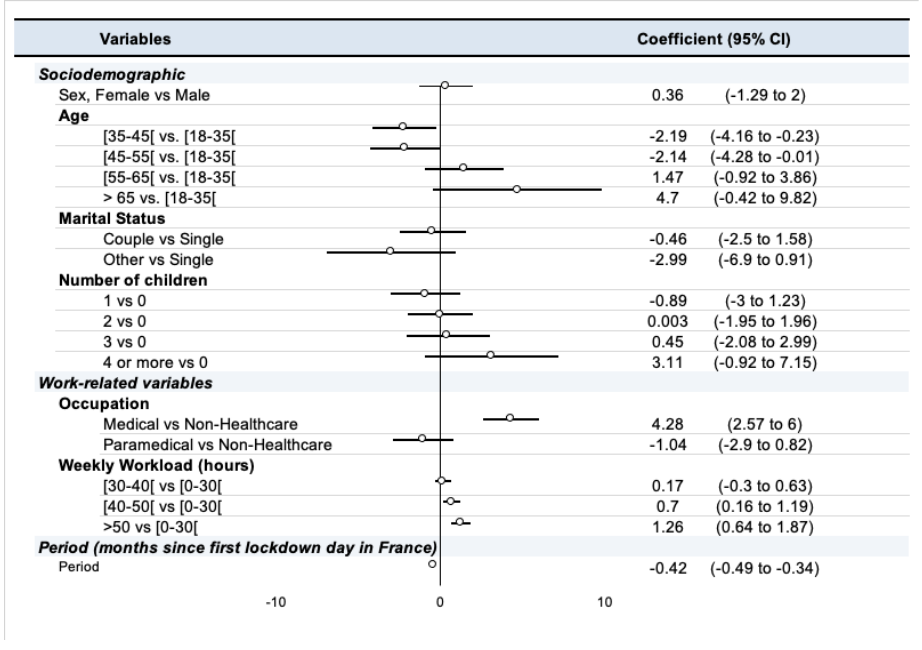
Figure 4. Summary of GEE model with exchangeable covariance structure (GEE ‐ ex).